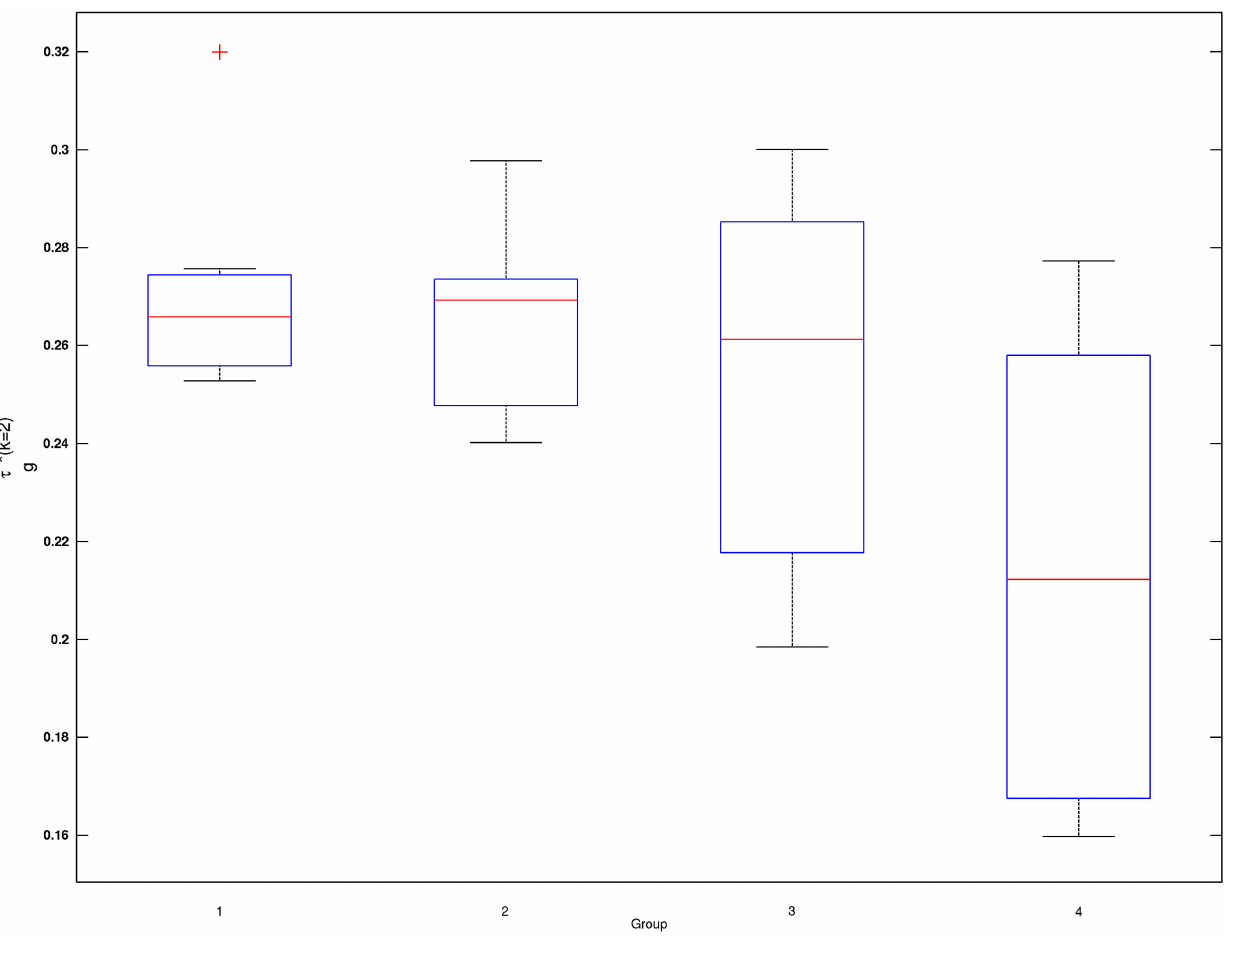
FIGURE 2 | Box plots of subject-wise mixing probabilities by each age group ( G = 1, 2, 3, 4). Subject-level estimated mixing probability to the second Gaussian density [ τ i ( k = 2), i = 1, ... , n ] is demonstrated for each of